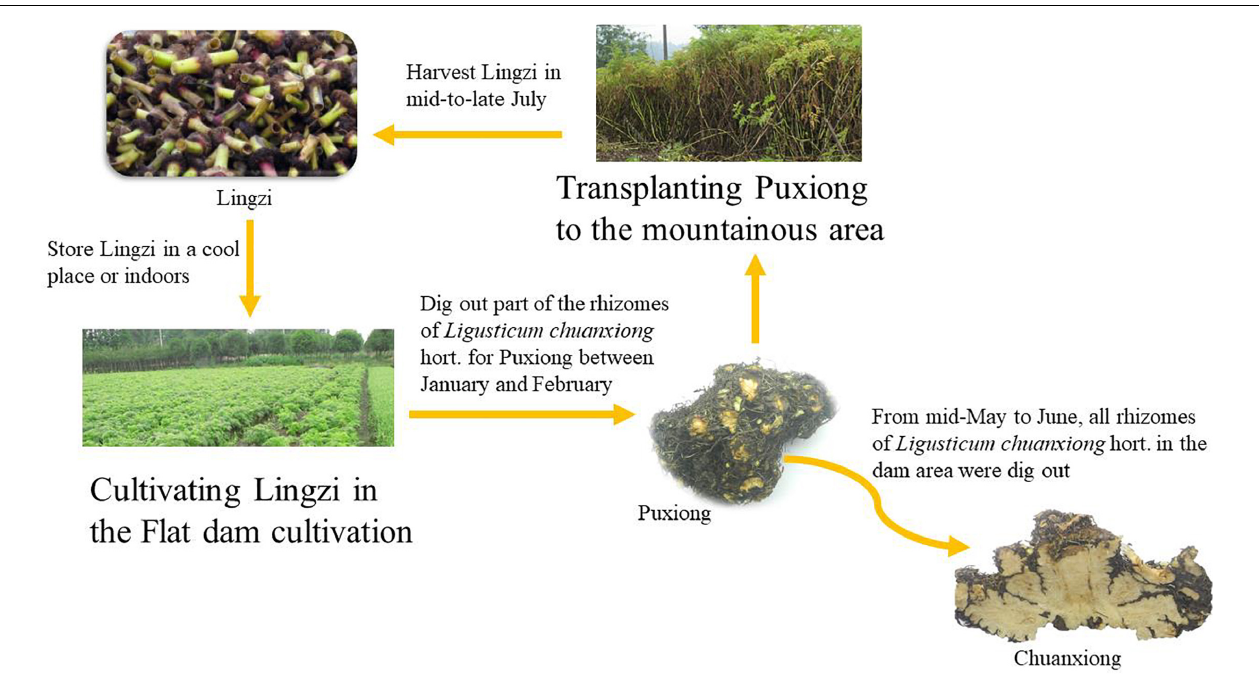
FIGURE 1 | Ligusticum chuanxiong cultivation cycle. Lingzi (LZ) refers to the stem nodes of L. chuanxiong ; PuXiong (PX) refers to the immature rhizome of L. chuanxiong ; ChuanXiong (CX) refers to the mature rhizome (medicinal materials) of L. chuanxiong .